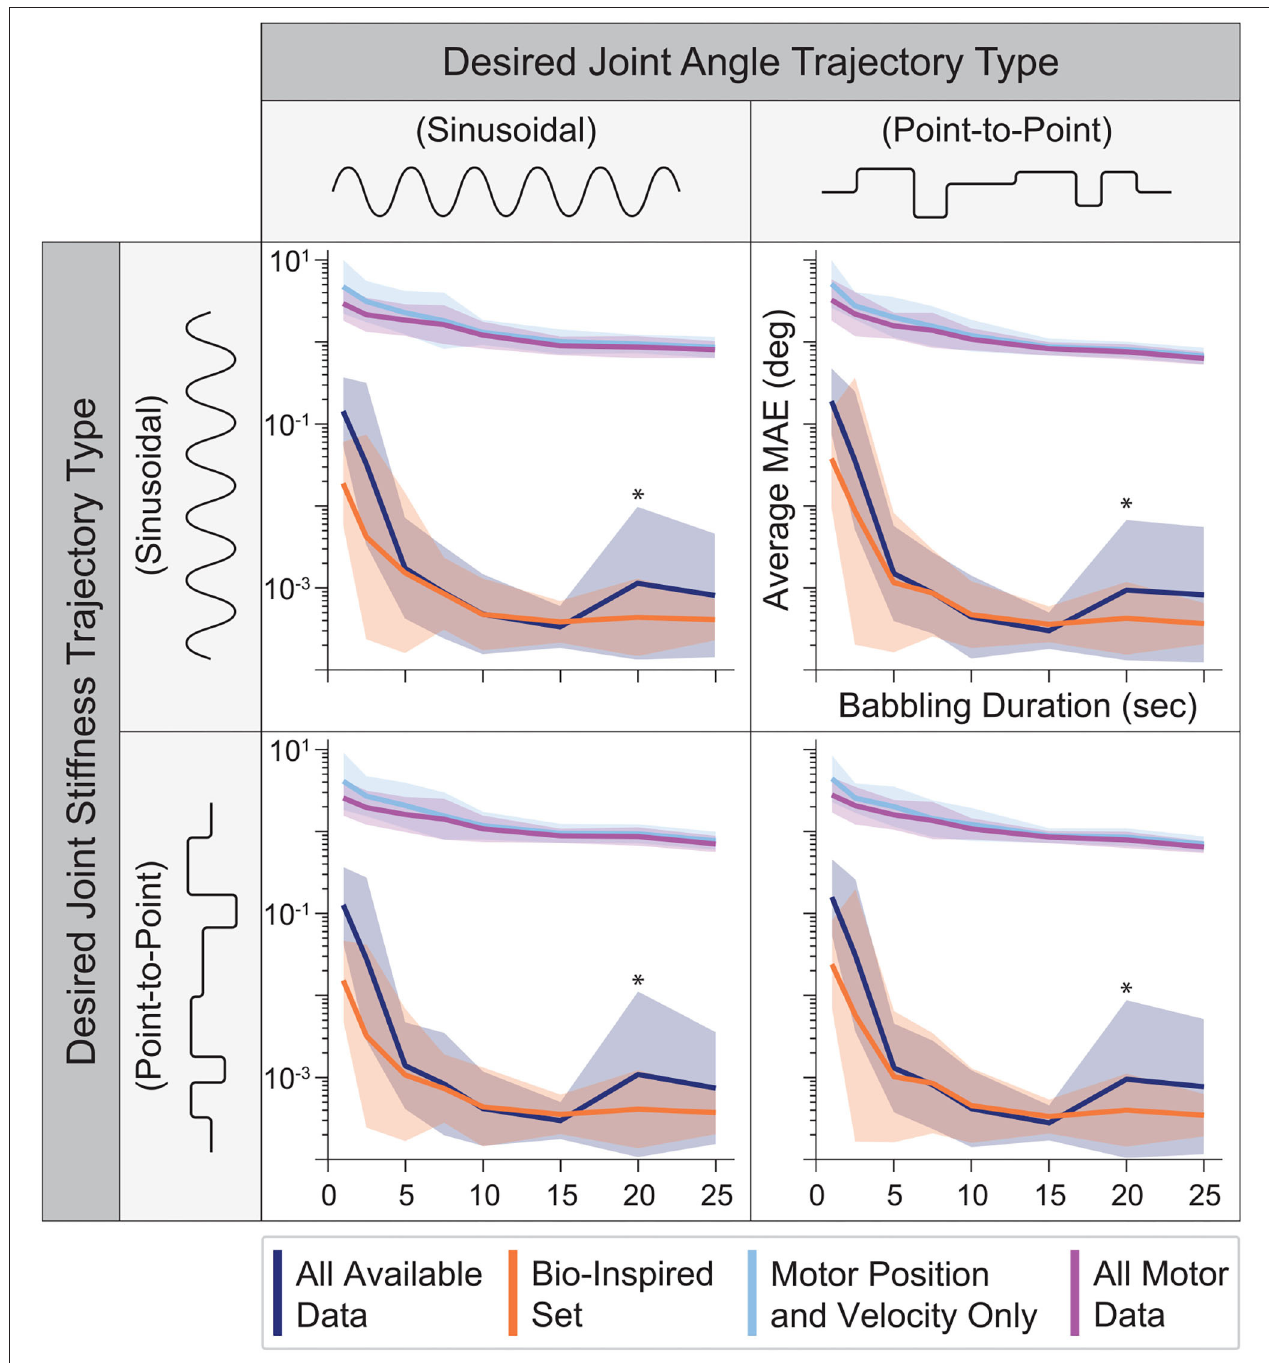
FIGURE 7 | The average performance (MAE) and relative standard deviation ( shaded region ) for each sensory set ( N = 25 ANNs, 15 hidden-layer nodes) plotted against the babbling durations used to train these networks for all four generalization movements. Those ANNs trained with tendon tension ( dark blue and orange ) drastically outperform those trained only with motor information ( light blue and purple ) with a 3 orders of magnitude improvement after as little as 5 s of training. Additionally, the Bio-Inspired Set performed as well as our baseline set ( All Available Data ), suggesting that tendon tension in addition to motor positions and velocities are sufficient to predict joint angles. *Note that because this plotted on a log scale, the peaks for both the All Available Data and Bio-Inspired Set at 20 s of babbling are on the order of 10 − 3 to 10 − 2 , and therefore do not reflect large variations from the average values but more likely noise.